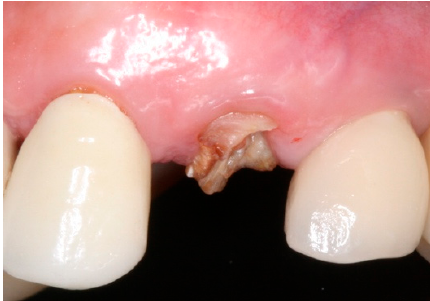
Figure 2. Osseodensification drill VT2838(3.3) (Versah LLC).